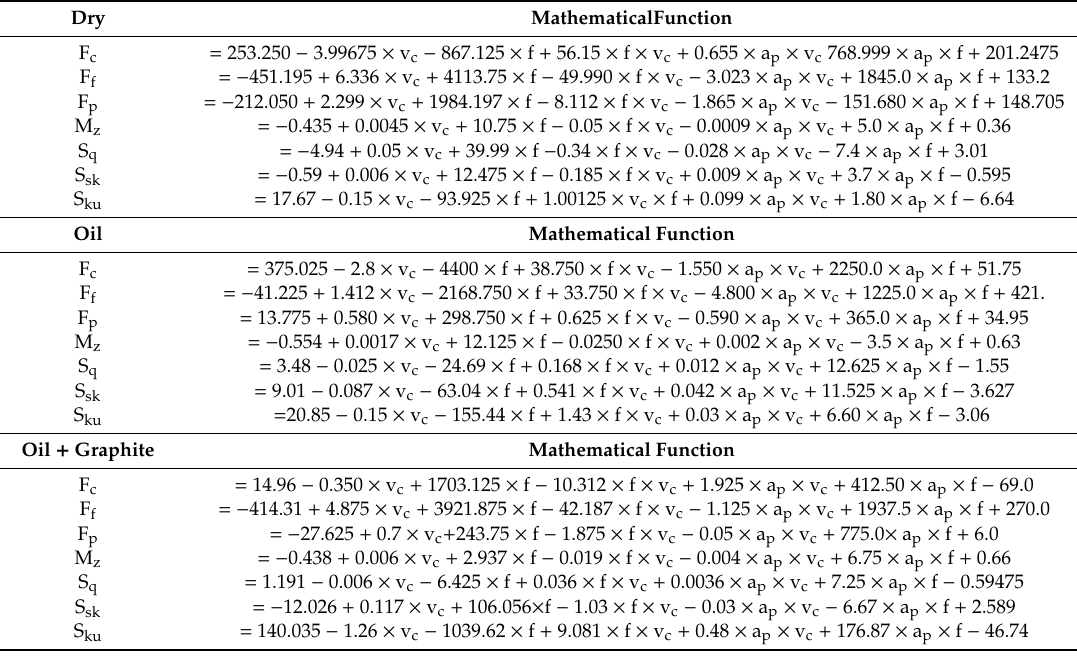
Table 9 lists the functions of the responses of the variables F c , F f , F p , M z , S sk , S ku and S q , obtained by the application of the factorial plan in this work. Table 9. Statistical functions for the prediction of dependent variables—Mathematical